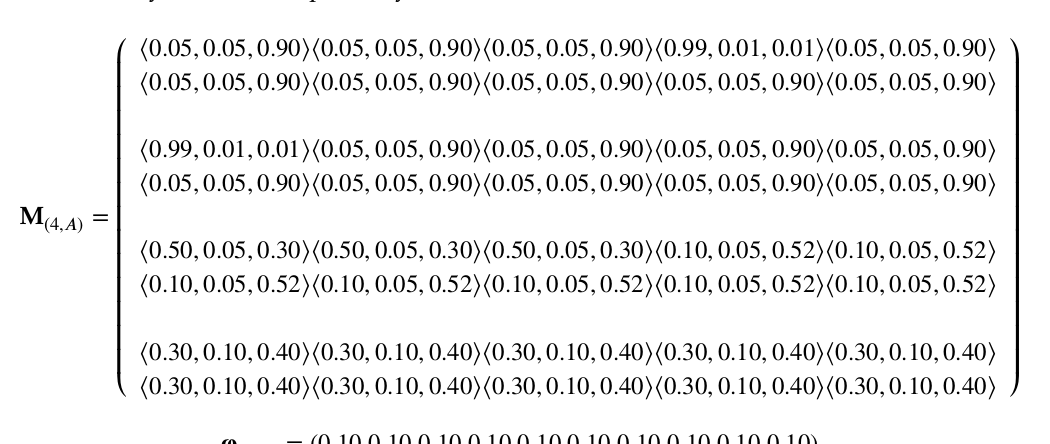
𝑡 A and GSF 𝑡 A for compliance of Test